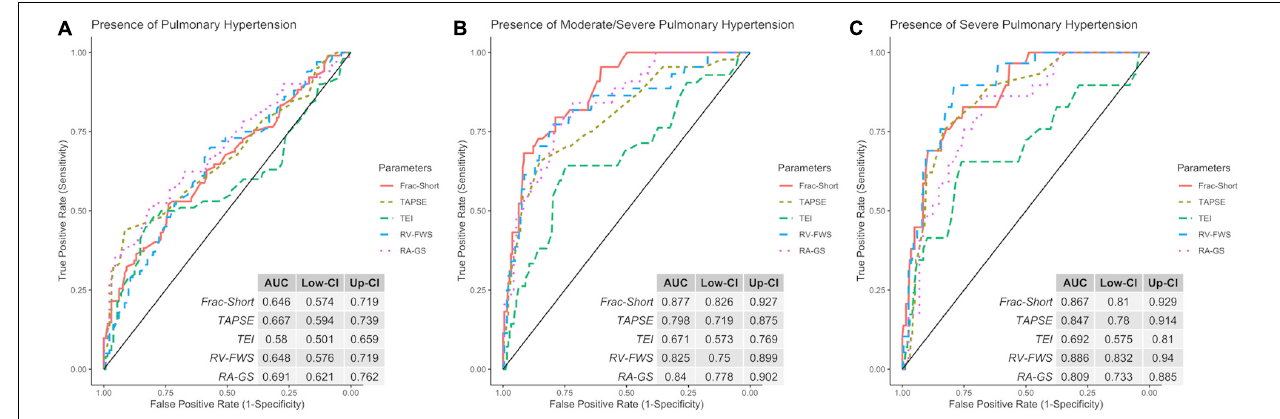
FIGURE 6 | Receiver operating characteristic (ROC) with the area under the curve (AUC) of echocardiographic parameters to identify the discrimination capacity for low (A) , intermediate/high (B) , and high (C) probability of PH. ROC, receiver operator characteristic; Frac-Short, fractional shortening; TAPSE, tricuspid annular plane systolic excursion; TEI, TEI index; RV-FWS, right ventricular free wall strain; RA-GS, right atrial global longitudinal